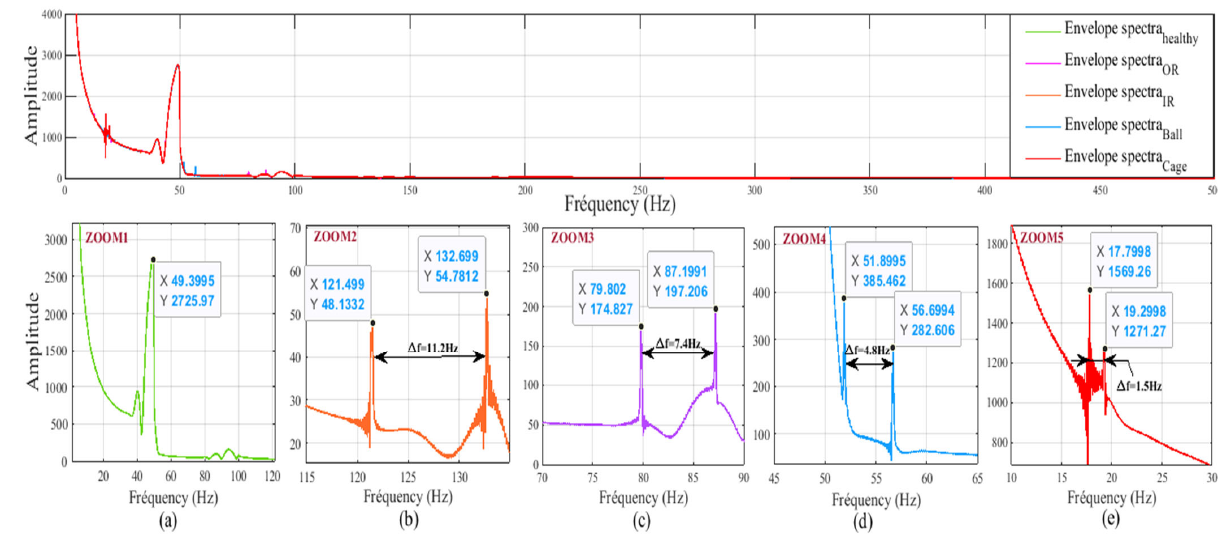
Figure 24. The current envelope spectra corresponding to the BD for two speeds ( top ). Zoom showing each spectrum: ( a ) Healthy state, ( b ) IR defect, ( c ) OR defect, ( d ) Ball defect, ( e ) Cage defect.